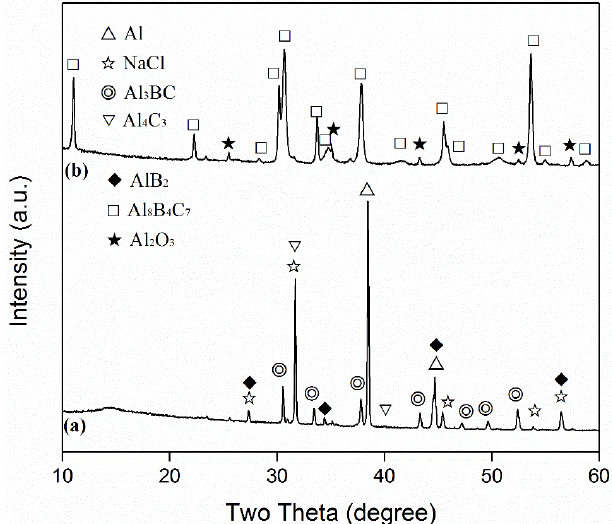
Figure 3. XRD patterns of: ( a ) the Al-B 4 C sample after 6 h of firing in 95%NaCl + 5%NaF at 1250 °C, and ( b ) the sample resulting from further firing of ( a ) with C in 95%NaCl + 5%NaF at 1250 °C for 6 h.